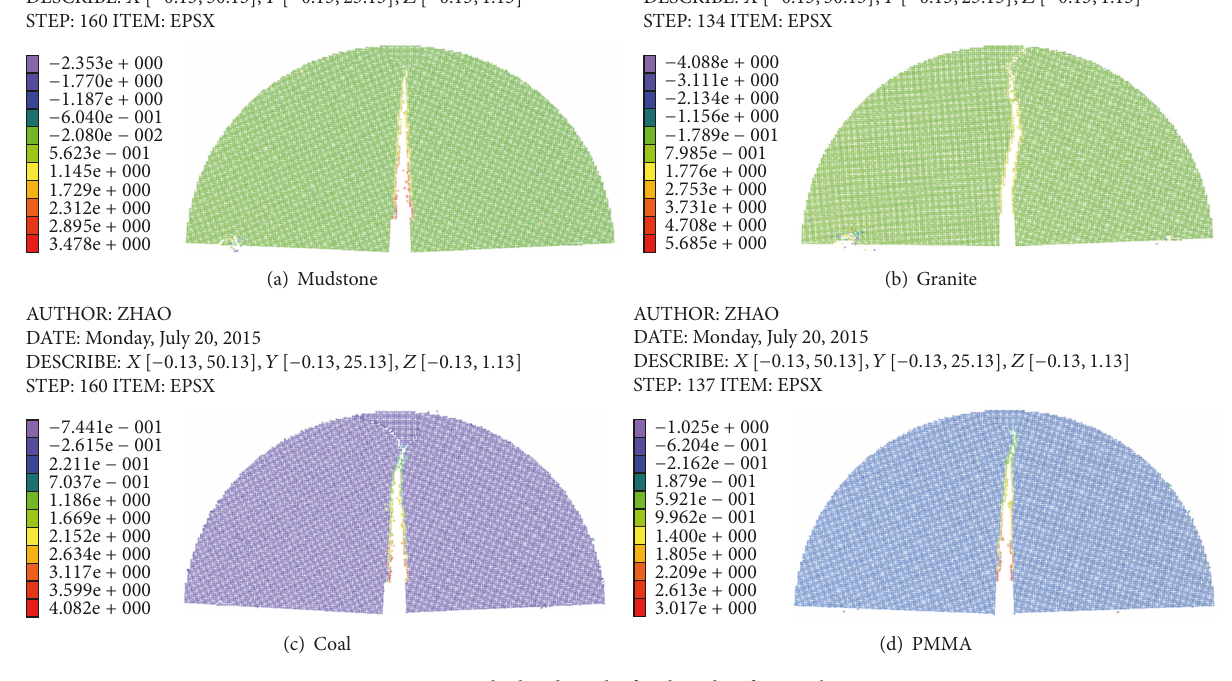
Figure 11: DLSM calculated results for the other four rock specimens.